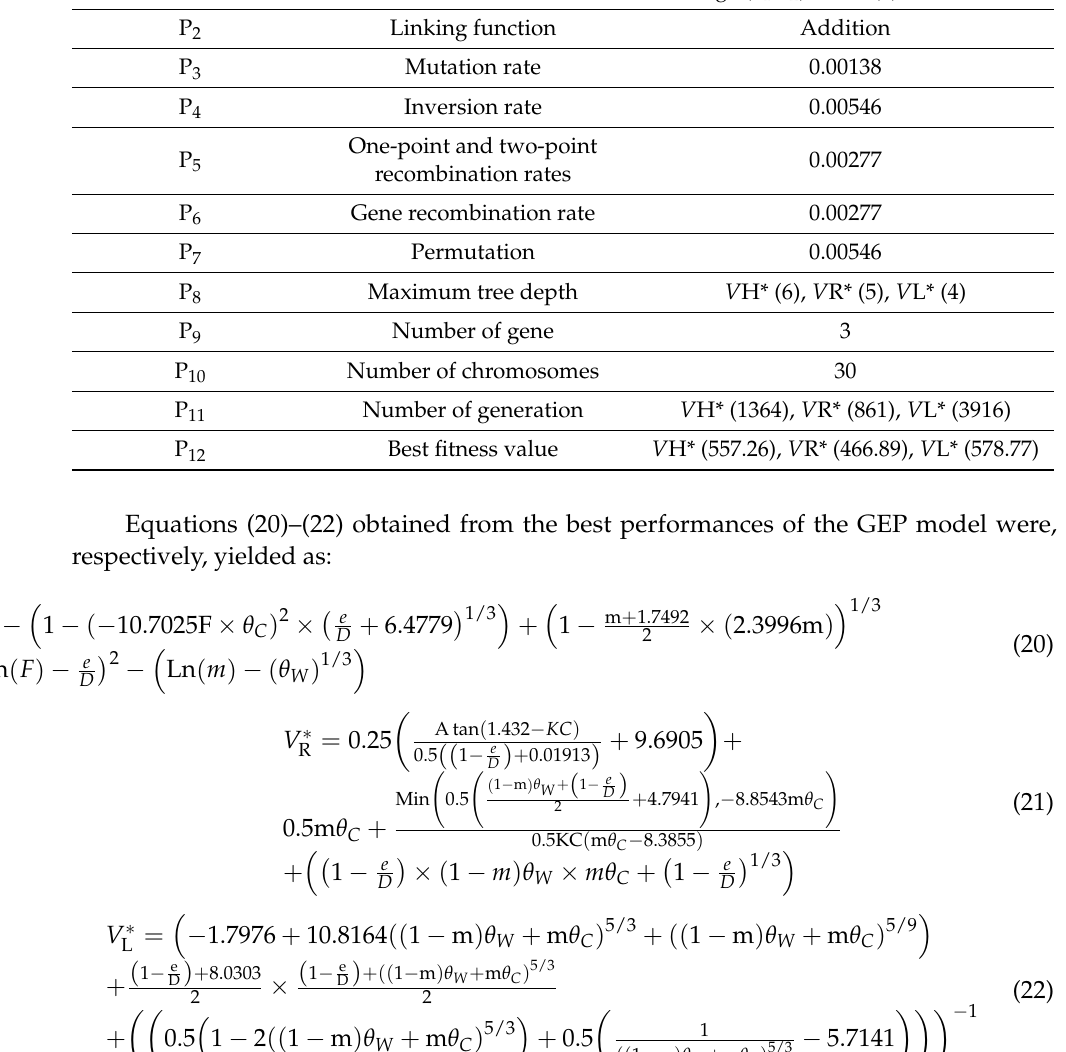
Table 4. Setting parameters of GEP performance in the calibration phases for 3D scour rates prediction. Parameters Description of Parameters Setting of Parameters Function